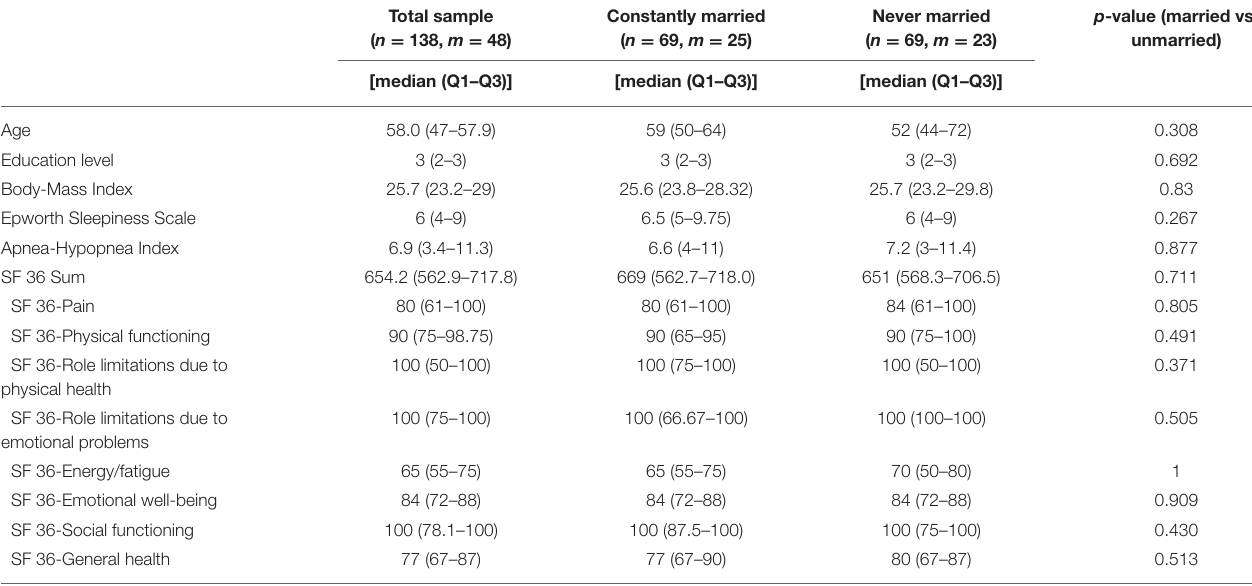
TABLE 1 | Sociodemographic and health parameters of the matched